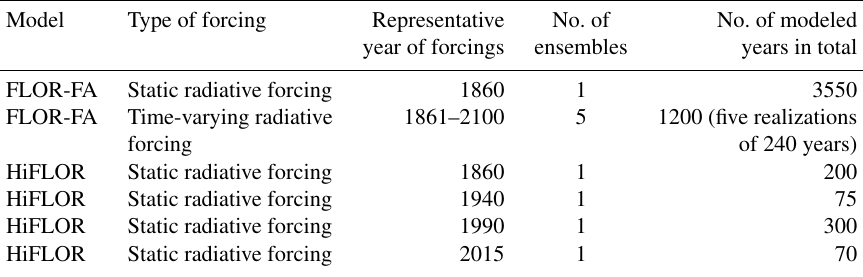
Table 1. Global coupled model experiments performed with the FLOR-FA and HiFLOR models.